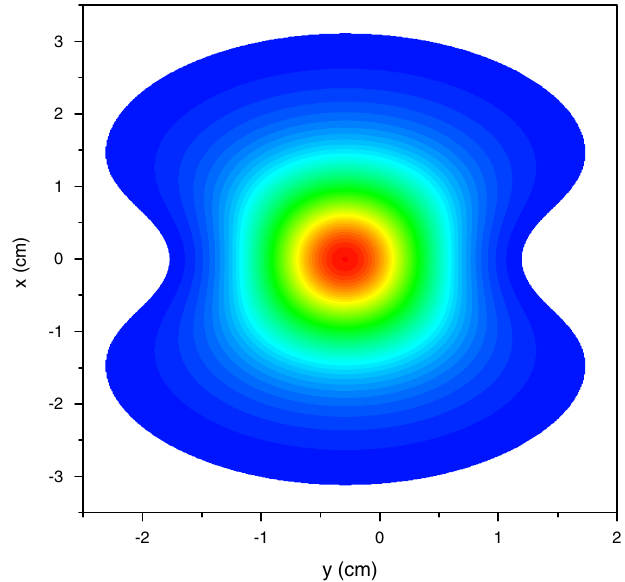
FIG. 6. (Color) The energy density collected on a plane sheet.